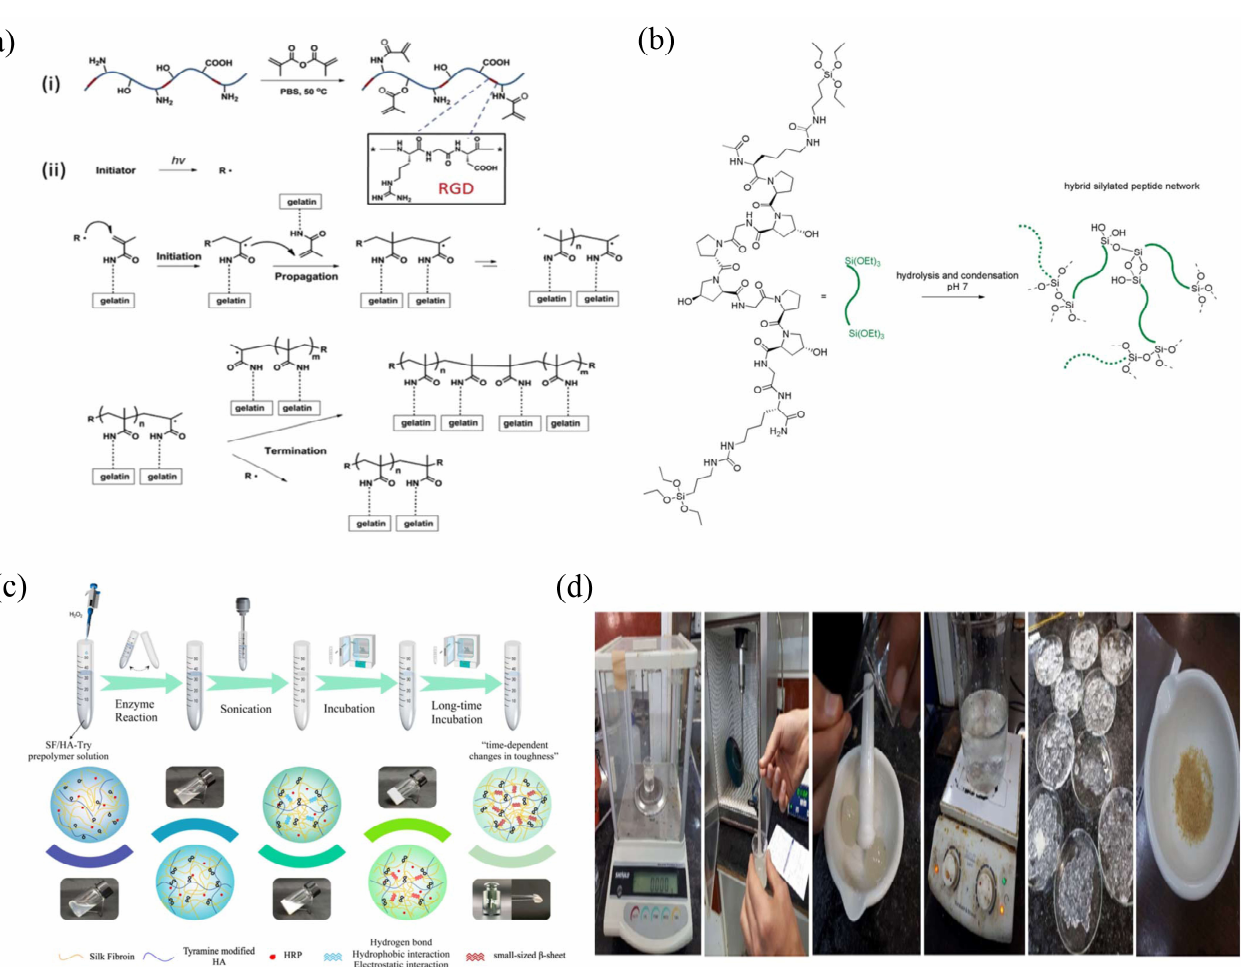
Figure 3. Preparation flow chart diagram of partial hydrogels. ( a ) Scheme for preparation of photo-crosslinked GelMA hydrogel (“*” in (i) denotes the left and right substituents of RGD; The “*” in (ii) stands for free radicals initiated by photocrosslinking agents). Reprinted with permission from Ref. [33]. Copyright 2022, Yue, K. ( b ) Bisilylated hybrid peptide as precursor for a cell-containing, collagen-inspired chemical hydrogel. Reprinted with permission from Ref. [36]. Copyright 2019, Echalier, C. ( c ) Schematic illustration of the preparation of the SF–HA composite hydrogels. Reprinted with permission from Ref. [39]. Copyright 2021, Qu, X.H. ( d ) Steps of synthesis of hydrogels containing starch by ultrasound (left to right). Reprinted with permission from Ref. [50]. Copyright 2021, Ebrahimi, R.